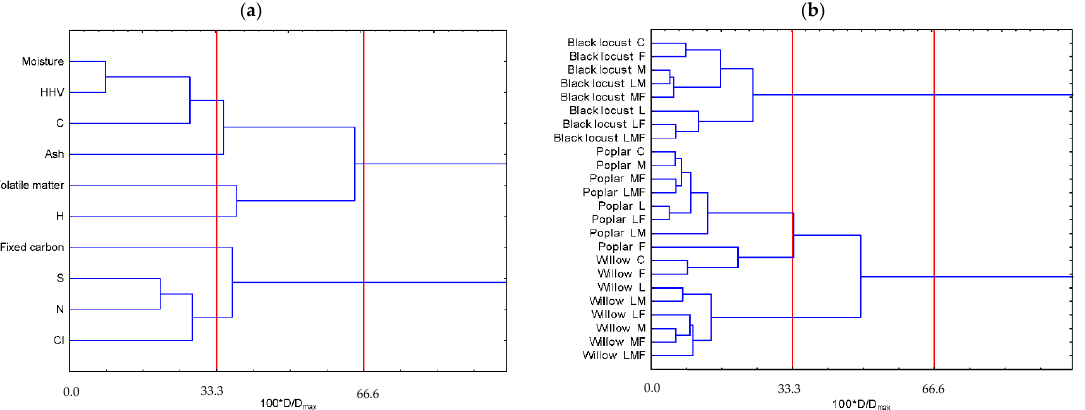
Figure 1. A dendrogram of a hierarchical cluster analysis illustrating the mutual similarities of the characteristics under study ( a ) and the SRWC species and the soil enrichment procedures ( b ). The red vertical line marks the Sneath criterion, (2/3 D max ) and (1/3 D max ). D—linkage distance; D max —maximum linkage Table 6. Selected statistical analysis indicators for the black locust characteristics under study.